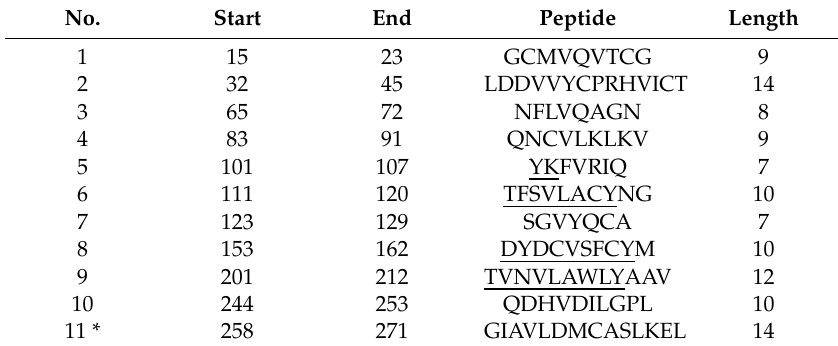
Table 1. Predicted antigenic B-cell epitopes of severe acute respiratory syndrome coronavirus 2 (SARS-CoV-2) main protease (Mpro).